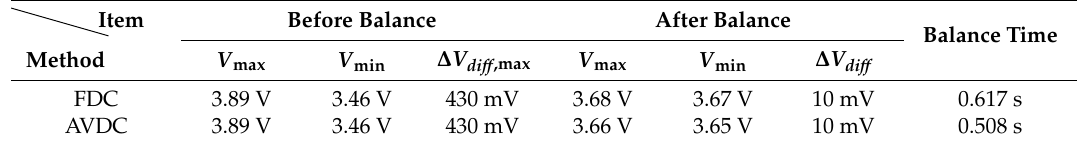
Figure 11. Battery voltage balance simulation curve run by: ( a ) the FDC method and ( b ) the AVDC method. Table 3. Comparison of balance simulation results. Table 3. Comparison of balance simulation